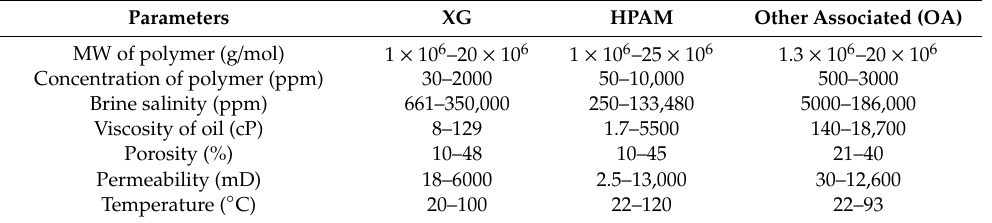
Table 3. Summarized range of laboratory (experimental) conditions for lab-scale polymer application.